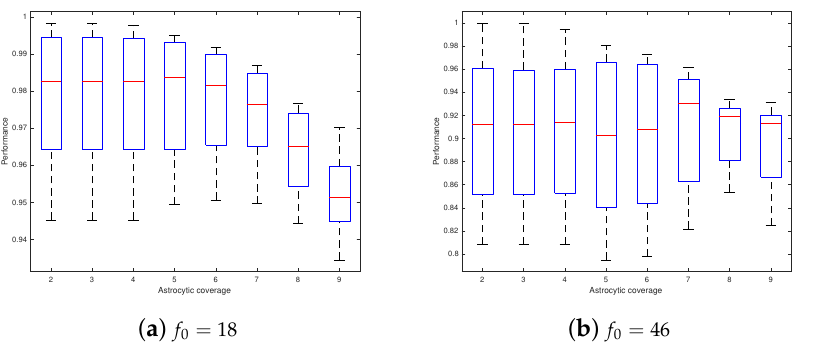
Figure 10. Short-term memory performance subject to two individual filter thresholds. The horizontal axis denotes the size of astrocytic coverage and the vertical axis denotes the performance score C p . At individual thresholds, f 0 = 18 is similar to the overall performance of the low thresholds; the highest median of f 0 = 46 is achieved at l = 7.